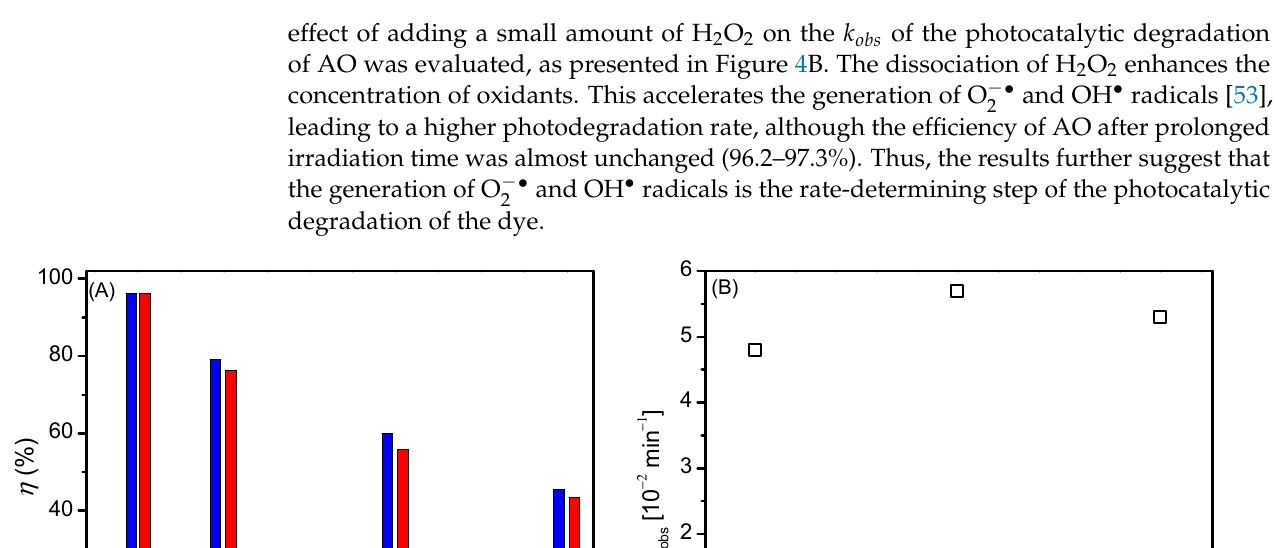
Figure 5. FTIR spectra of AO ( A ) before and ( B ) after photocatalytic degradation.